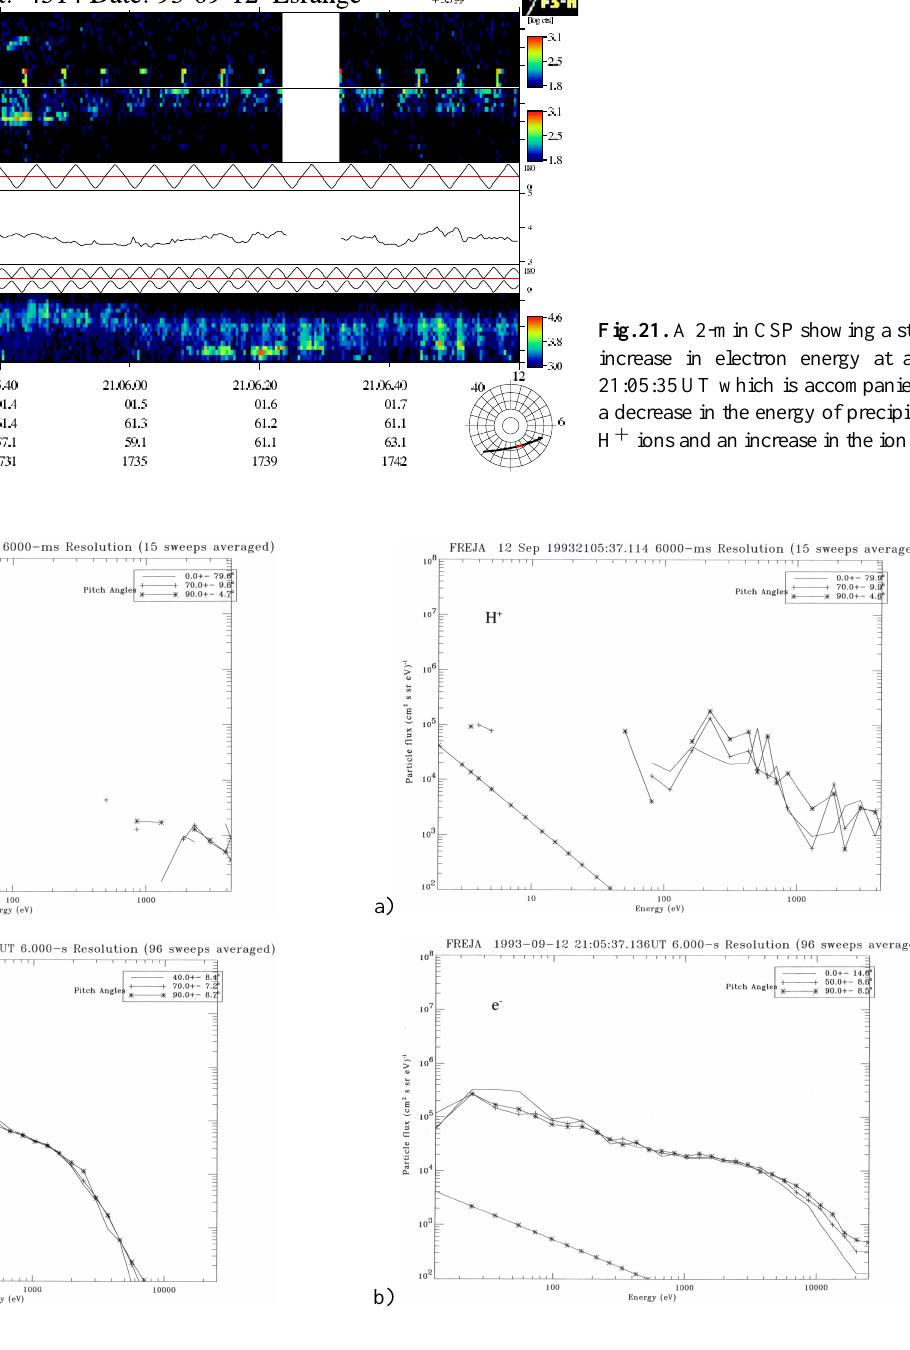
Fig.22. Measured energy spectra of H + ions (a) and electrons (b) before the increase in electron energy in Fig.21. Straight lines show 1-count levels.